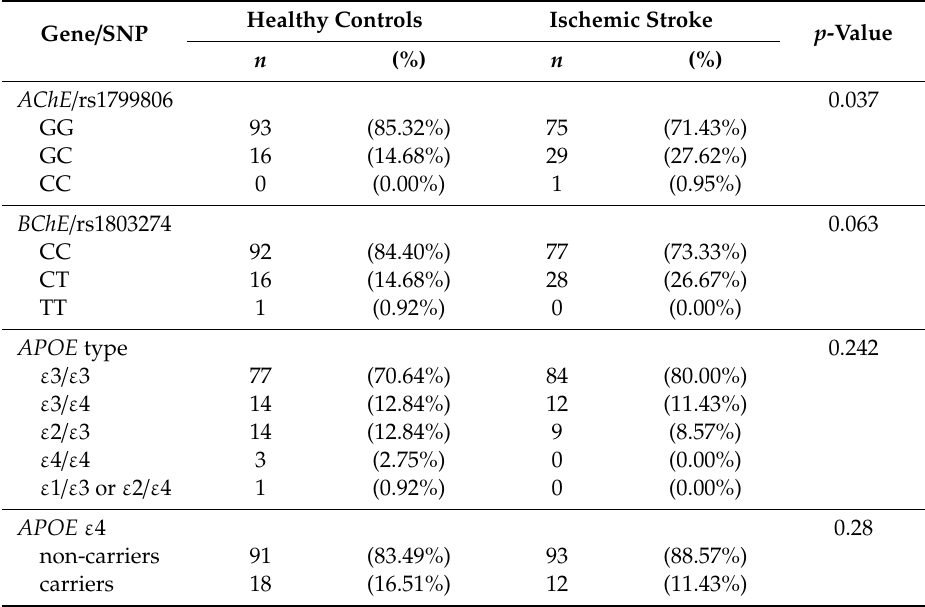
Table 3. AChE , BChE and APOE associated with ischemic stroke and healthy controls.